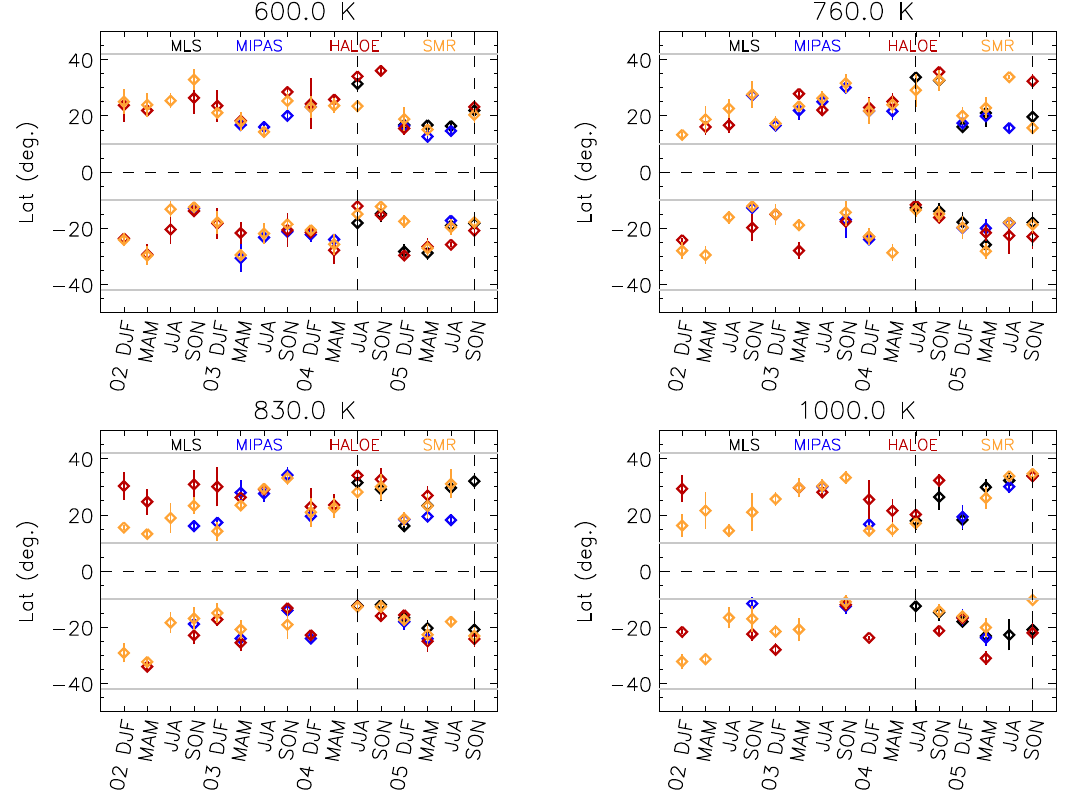
Fig. 4. Time series (seasonal data) of the subtropical barrier position from DJF 2002 to SON 2005 calculated from MLS (black), MIPAS (blue), HALOE (red), and SMR (yellow) data. Error bars are superimposed to each data point. The horizontal grey lines define the latitude region between 10 and 42 degrees in both hemispheres, while the vertical dashed lines indicate the overlapping time period of all four satellite data.